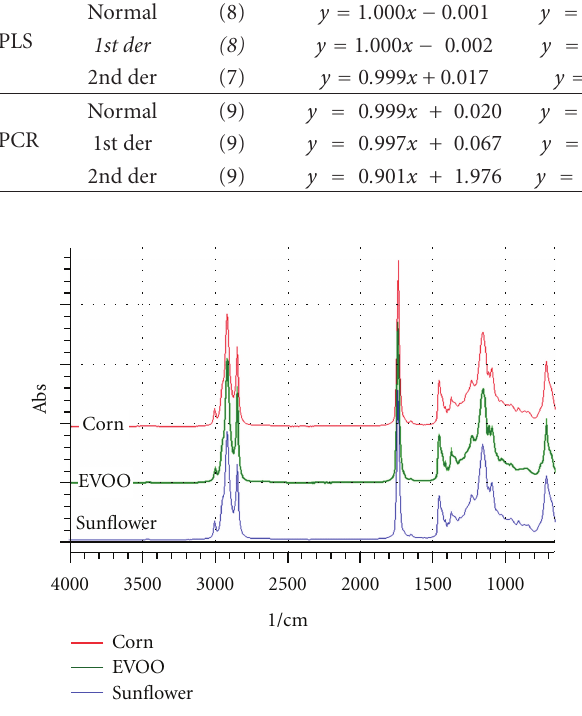
Figure 1: FTIR spectra of extra virgin olive oil, corn oil, and sun- flower oil scanned at wavenumbers of 4000–650